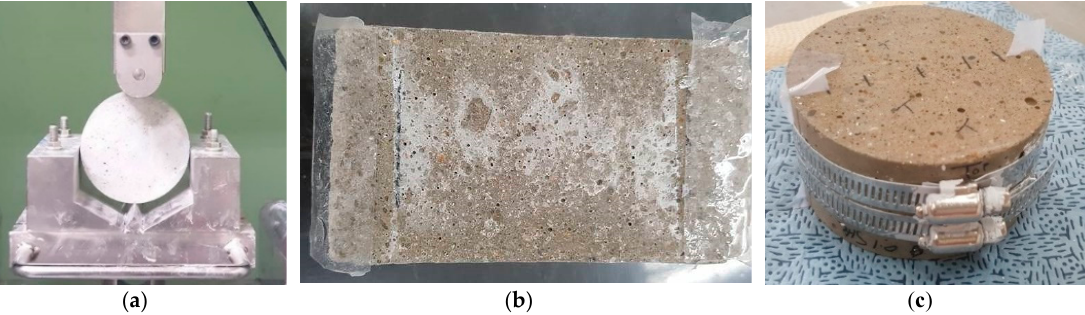
Table 2. Mixture proportions, slump flow, and compressive strengths of the test specimens.